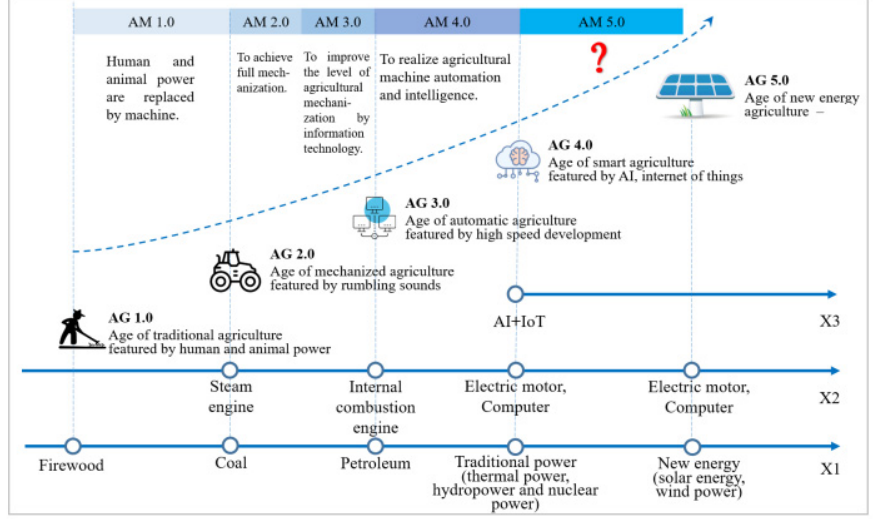
Figure 2. The trend of agriculture development. Source: Huang et al.